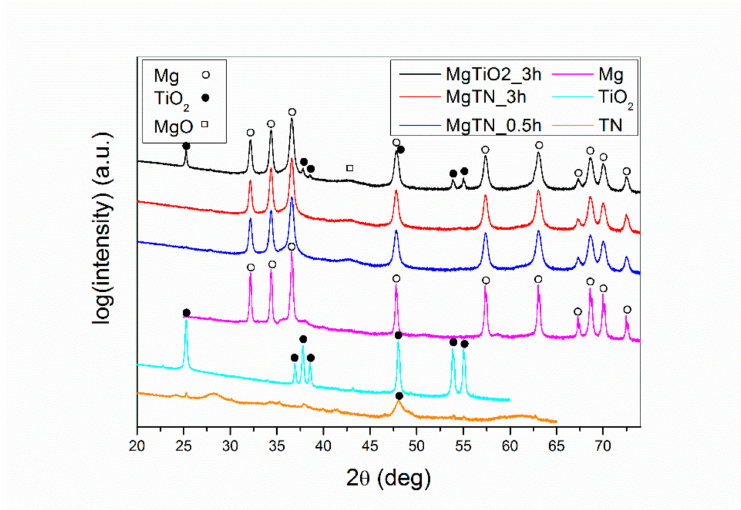
Figure 2. X-ray powder di ff ractograms of commercial Mg, TiO 2 powders, as-prepared titanate (TN) nanotubes and the as-milled MgTiO2_3h, MgTN_0.5h and MgTN_3h